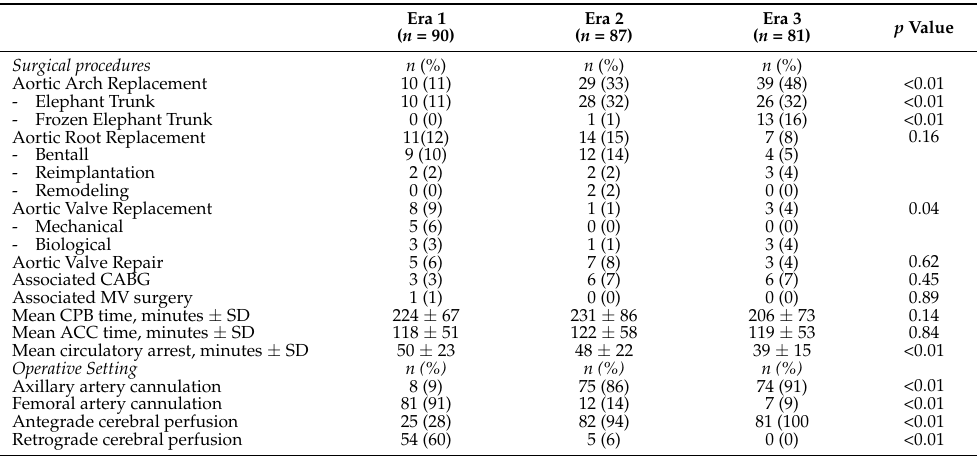
Table 2. Surgical